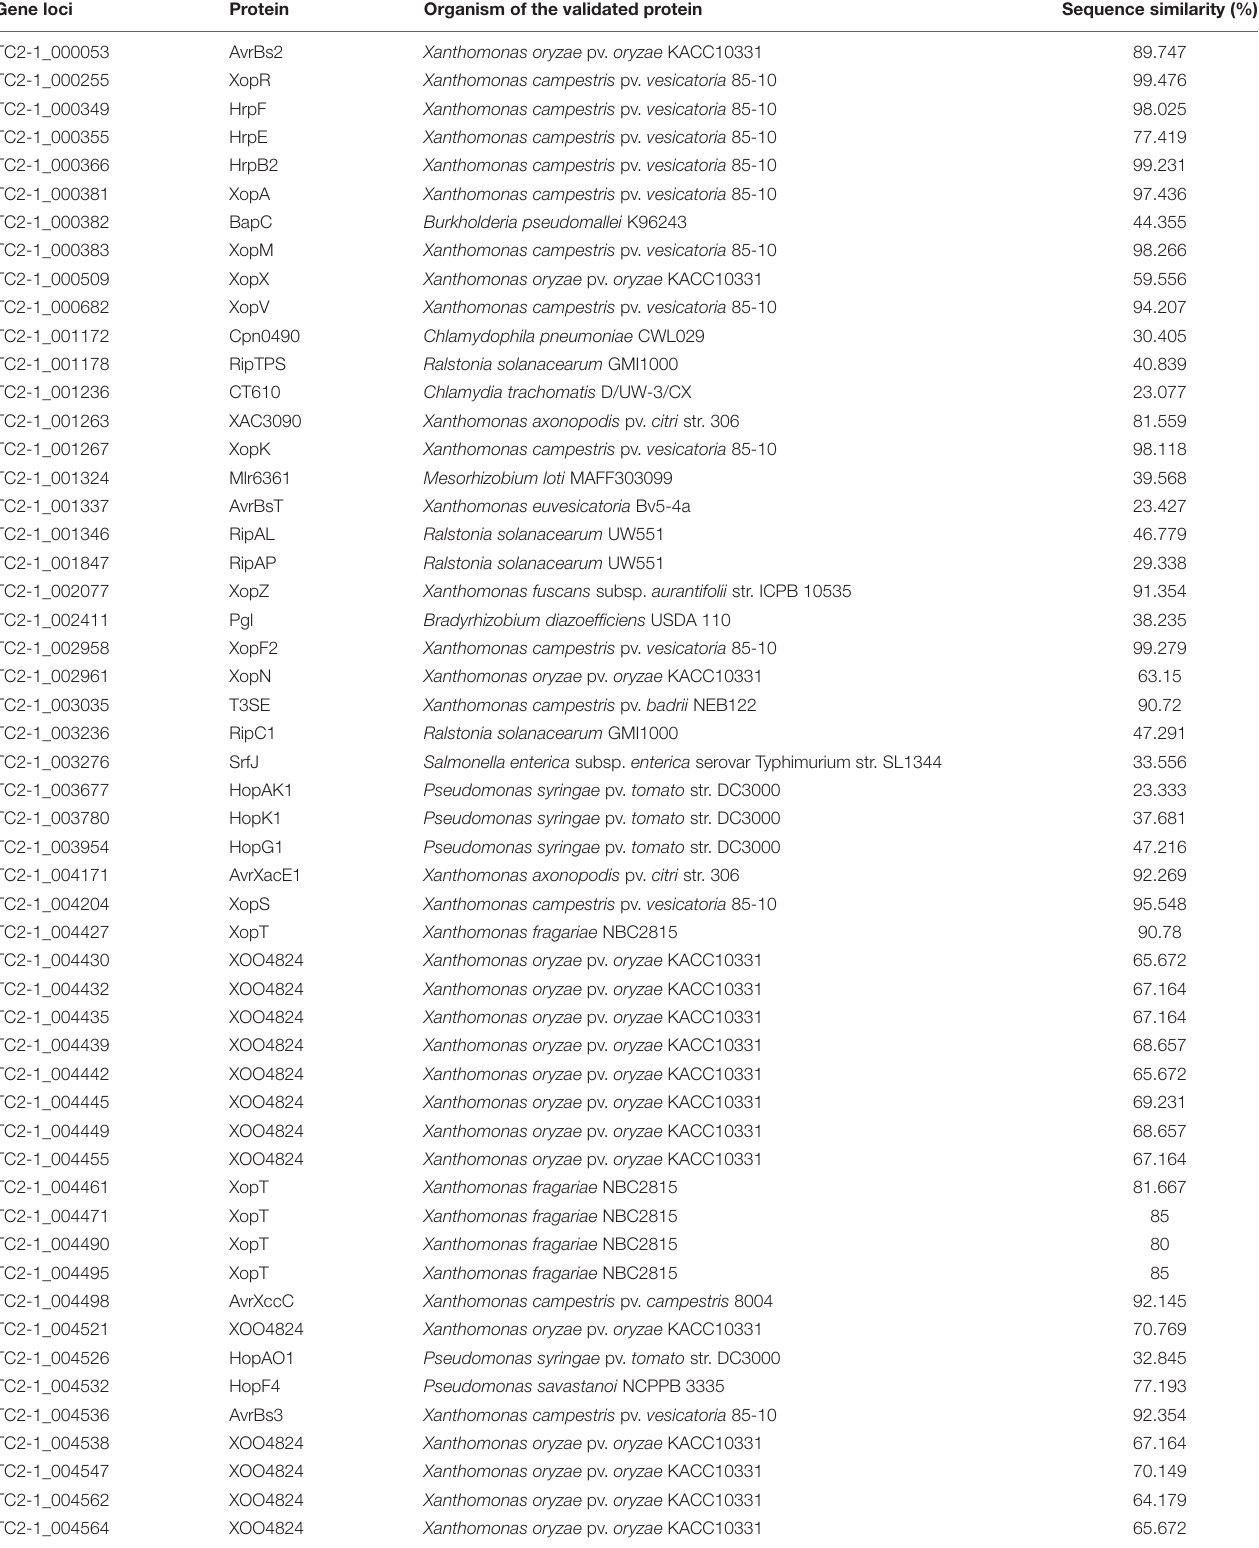
TABLE 2 | Homolog of T3SE genes in X. perforans TC2-1. Gene loci Protein Organism of the validated protein Sequence similarity